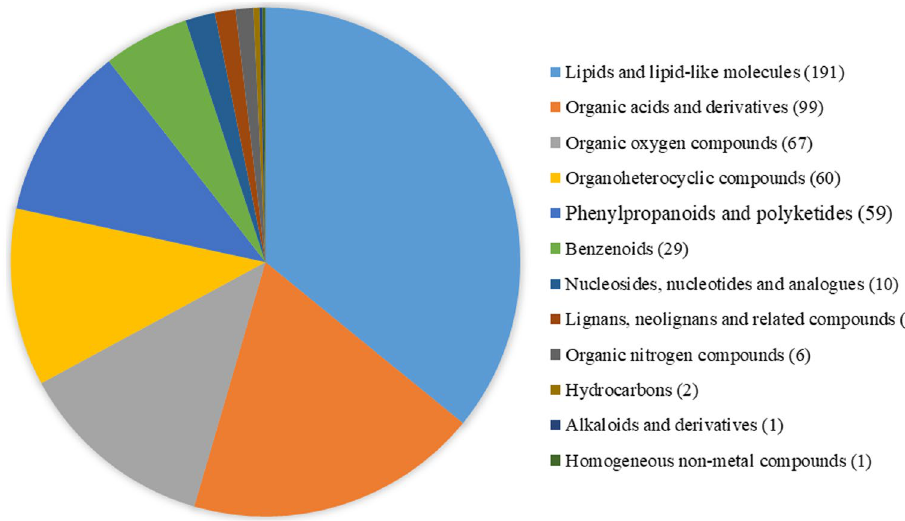
Figure 3. Classification of all identified metabolites at the superclass level.